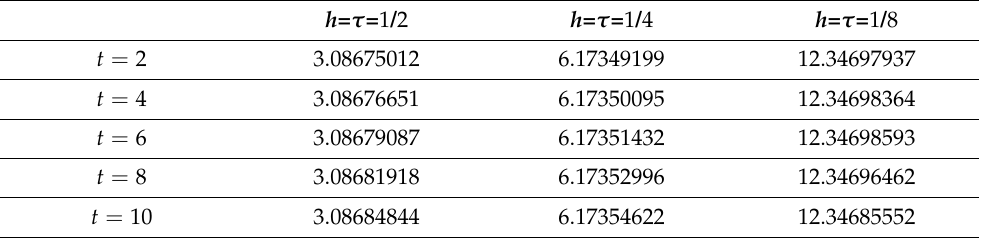
Table 3. Discrete E n values at different times with various h and τ